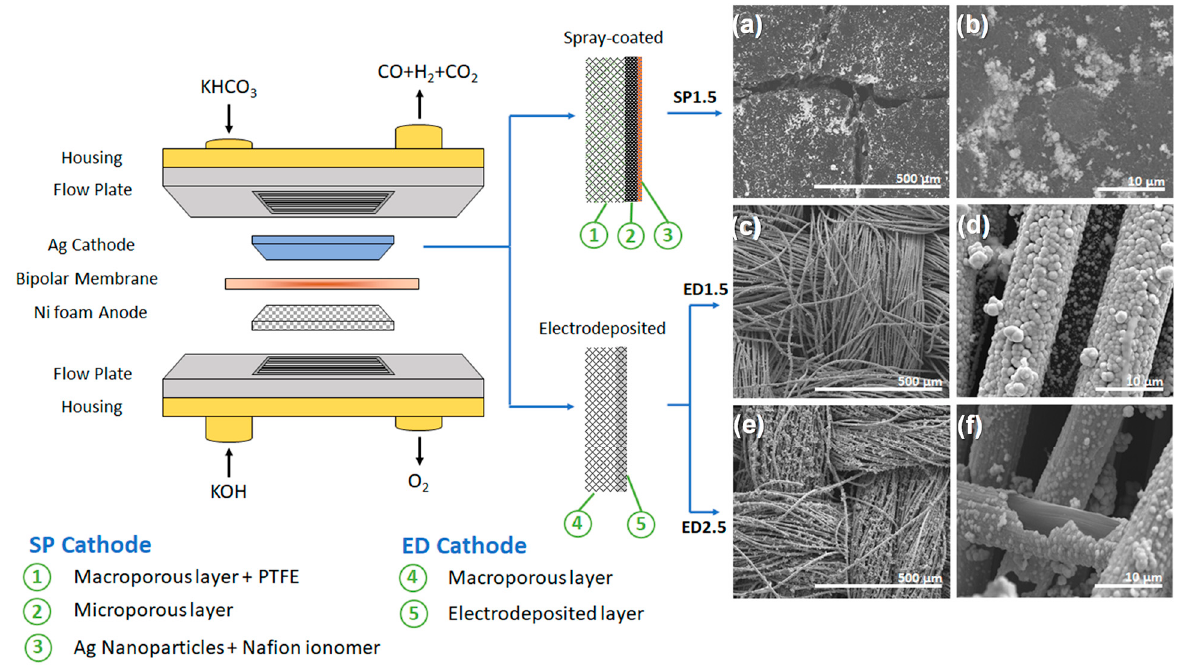
Figure 1. Electrochemical cell assembly and its components. Three different Ag cathodes were tested: one containing spray-coated Ag nanoparticles (SP1.5) and two with electrodeposited Ag (ED1.5 and ED2.5). The cathodes were observed through SEM: ( a , b ) SP1.5, ( c , d ) ED1.5, ( e , f ) ED2.5.